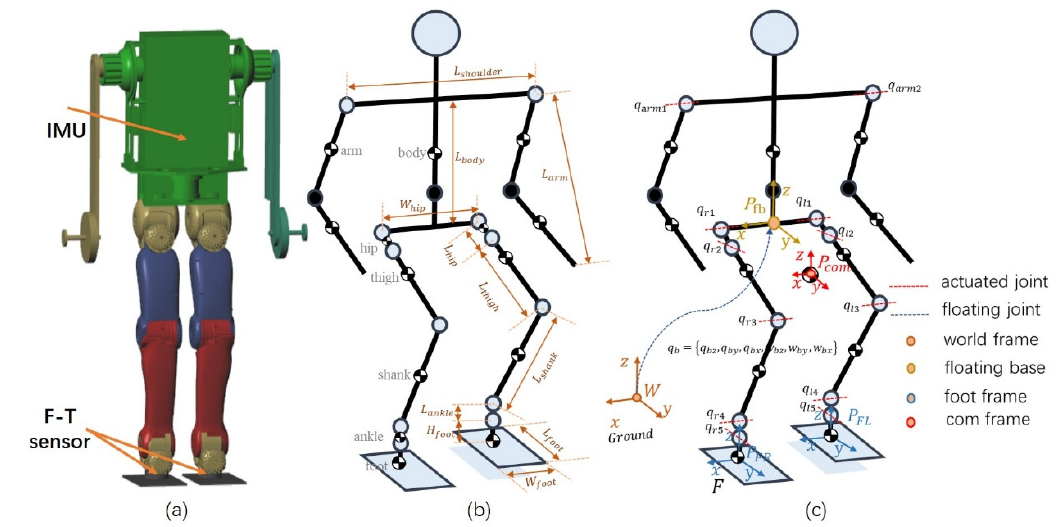
Figure 4. Typical motor-driven humanoid robot. They always have an inertial measurement unit (IMU) fixed inside the chest and a six-dimensional force torque (F-T) sensor for each ankle. Each leg has five degrees of freedom (DoFs): ( a ) Simulation model; ( b ) model mechanical parameters; ( c ) DoFs configuration.